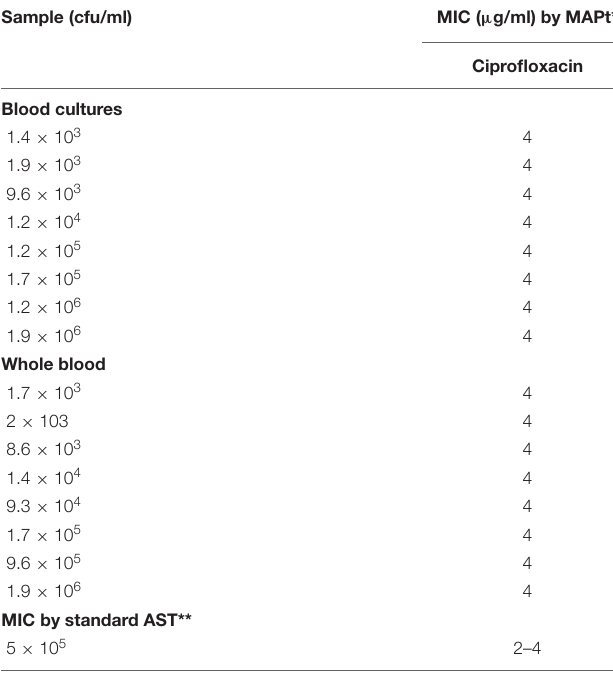
TABLE 7 | MIC values for doxycycline obtained by MAPt of blood cultures and whole blood samples inoculated with Y. pestis derivatives with reduced susceptibility to